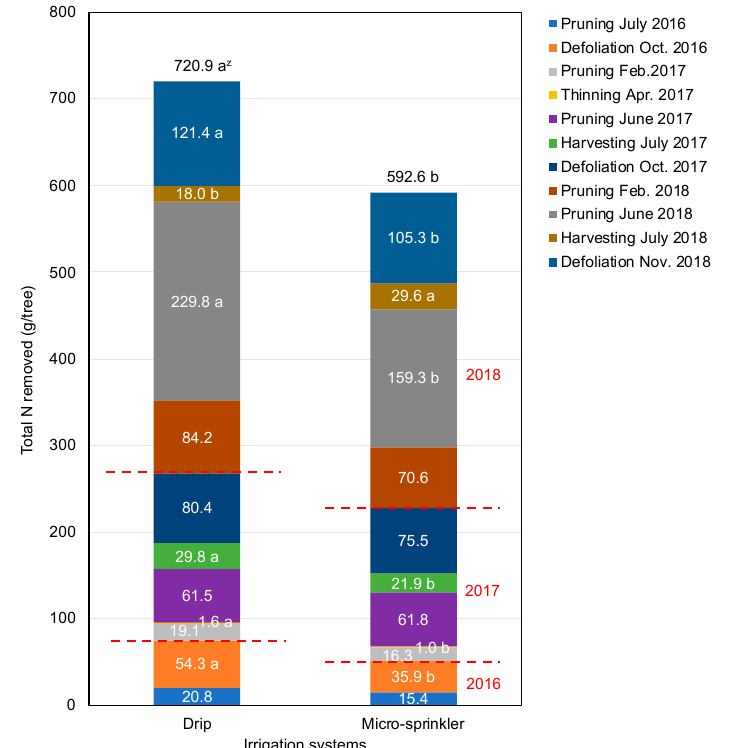
Figure 6. Total N removed per tree for the different irrigation systems (drip vs. micro-sprinkler) of “Julyprince” peaches in 2016, 2017, and 2018. For each removal event (different colors), the means are shown inside the bars. z Means followed by a different letter within a removal event are significantly different by Tukey’s honestly significant different test, P ≤ 0.05. Means without letters indicate non-statistical differences, P > 0.05. Table 6. Dry weight (DW) and N concentration in the different removal events for drip- vs. micro- sprinkler-irrigated for trees of “Julyprince” peaches in 2016, 2017, and 2018. Dry Weight (g/tree) Removal Event P Value Drip